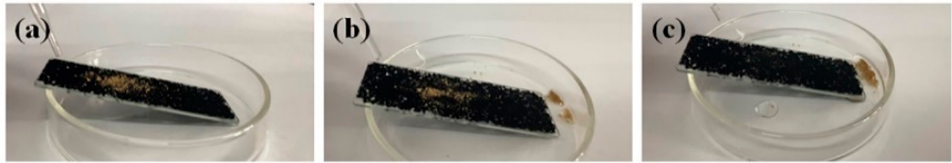
Figure 8. Pictures of self-cleaning test: ( a ) the superhydrophobic composite coating with river sands to be tested; ( b , c ) pictures in the test.